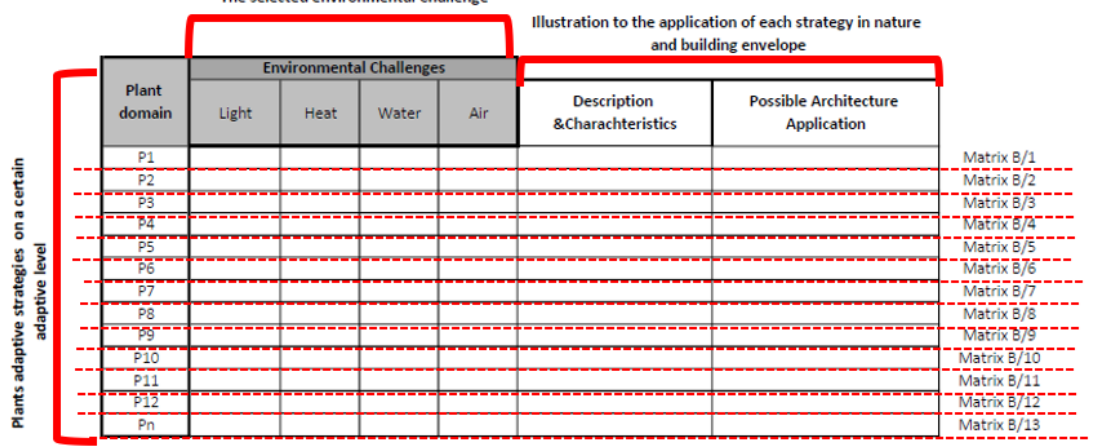
Figure 11 : Matrix (B) description and segmentation (the researcher, 2020)